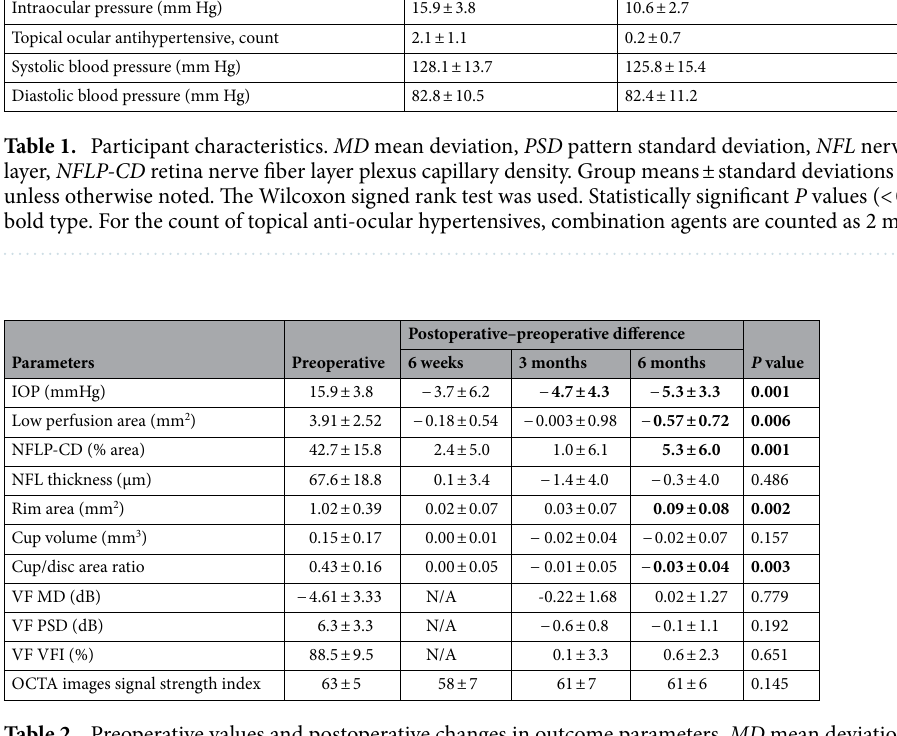
Table 2. Preoperative values and postoperative changes in outcome parameters. MD mean deviation, PSD pattern standard deviation, VFI visual field index, NFL nerve fiber layer, NFLP-CD retina nerve fiber layer plexus capillary density, OCTA optical coherence tomography angiography. Group means ± standard deviations are shown . P values are from the Friedman test to compare the preoperative values and the 3 postoperative values. Statistically significant differences between any one postoperative visit and the preoperative visit ( P < 0.05/3, Wilcoxon test with Bonferroni correction for 3 postoperative visits) are shown in bold type.